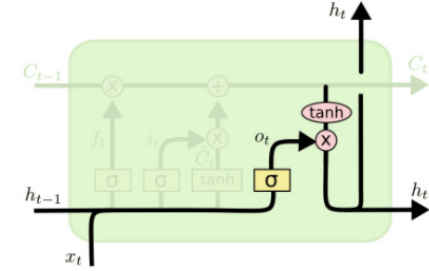
Figure 6. A section of the of an LSTM showing (a) forget gate, (b) hidden gate [37].